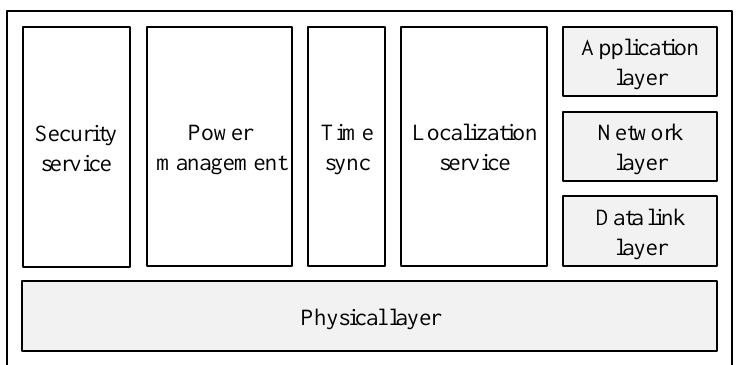
Figure 3. Cross layer protocol